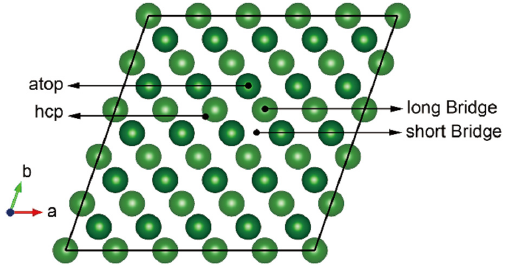
Figure 2. Top view of Fe (110) supercell and four different adsorption sites.